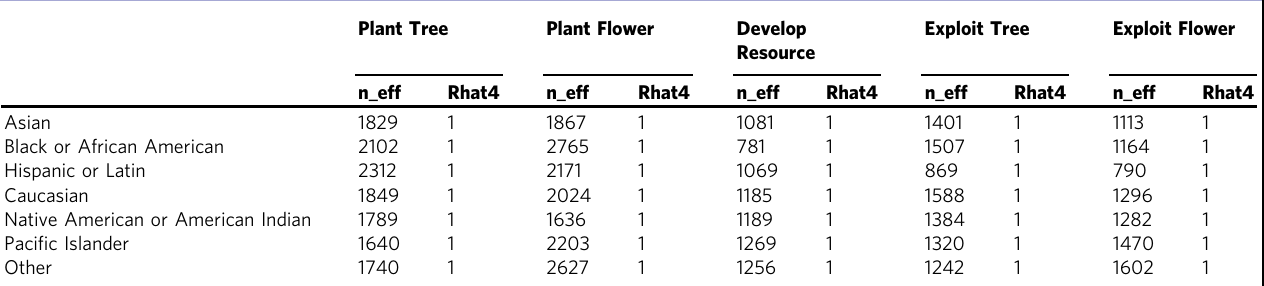
Table 4 MCMC diagnostic criteria for the